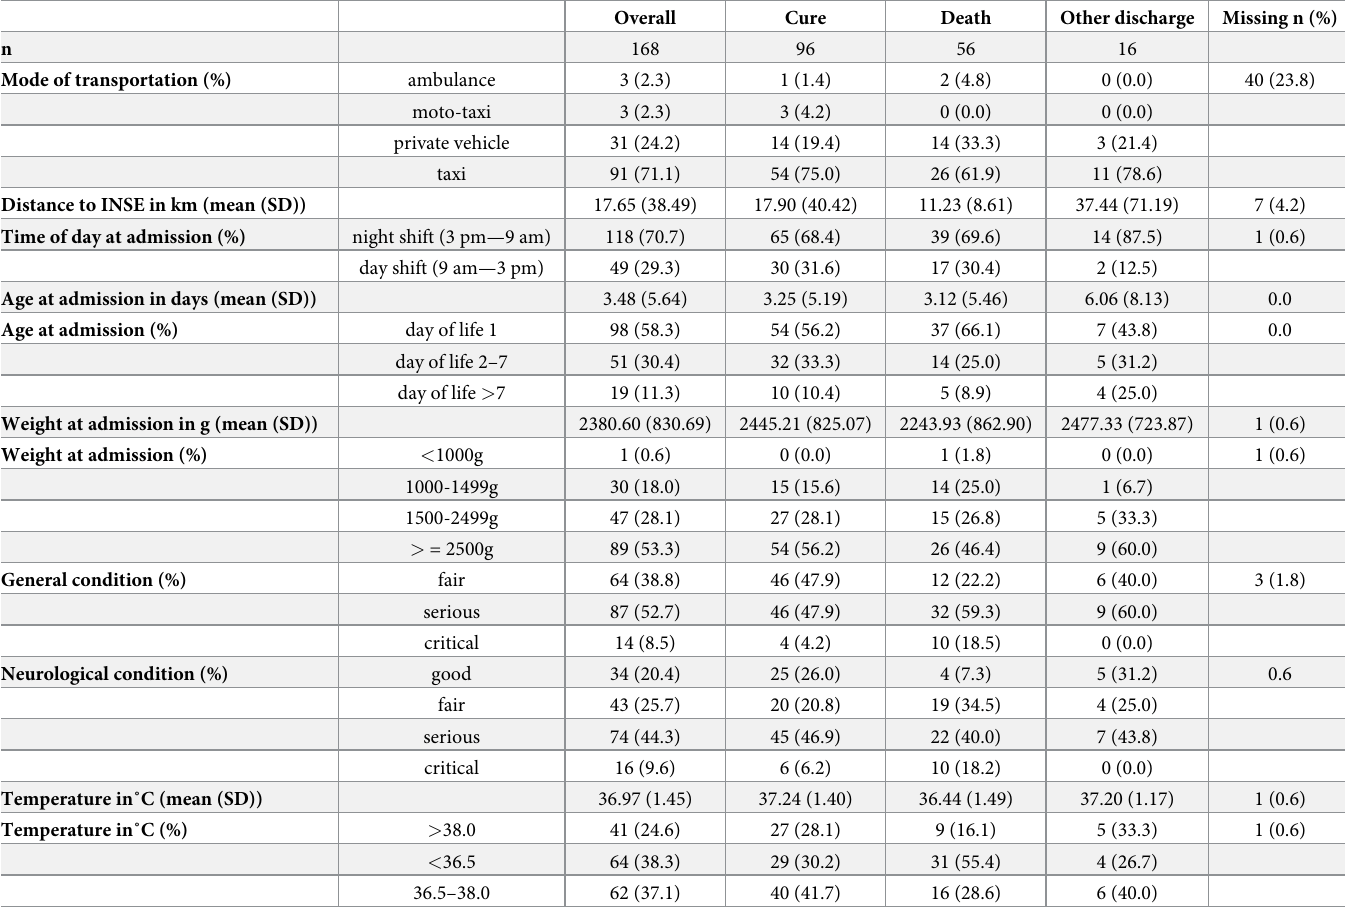
Table 5. The characteristics at the moment of admission to INSE, stratified by neonatal outcome (cure or death during hospital stay or other